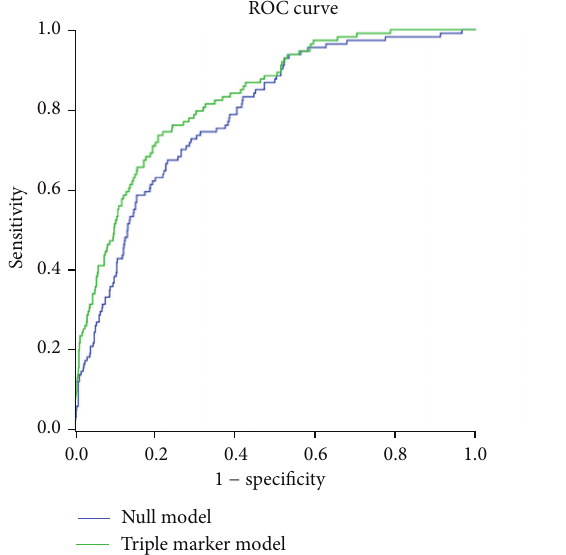
Figure 2: Receiver operating characteristic (ROC) curves compar- ingthenullmodel(age,gender,bodymassindex,systolicBP,HbA1c, and diabetes duration) with the triple marker model (eGFR cr + eGFR cys + albuminuria, in addition to the variables included in the null